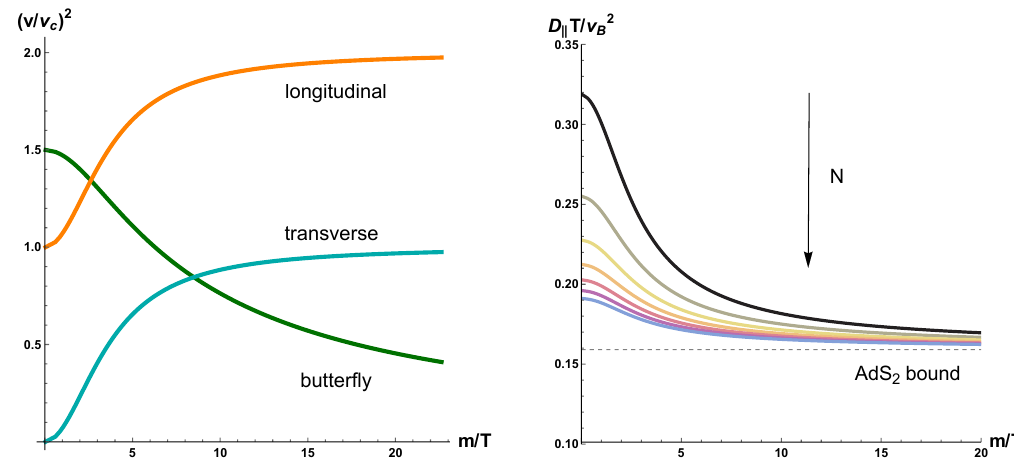
Figure 4: Left: The characteristic velocities in the holographic systems with SSB of translations. We fixed N = 3. In orange the speed of longitudinal sound; in cyan the speed of transverse sound and in green the butterfly velocity. All the speeds = 1 / 2. Right: The dimensionless ratio are normalized by the conformal value v 2 c D (cid:107) T / v 2 in function of m / T for various N ∈ [ 3,9 ] (from black to blue). The dashed B line is the AdS universal value 1 / 2 π 2